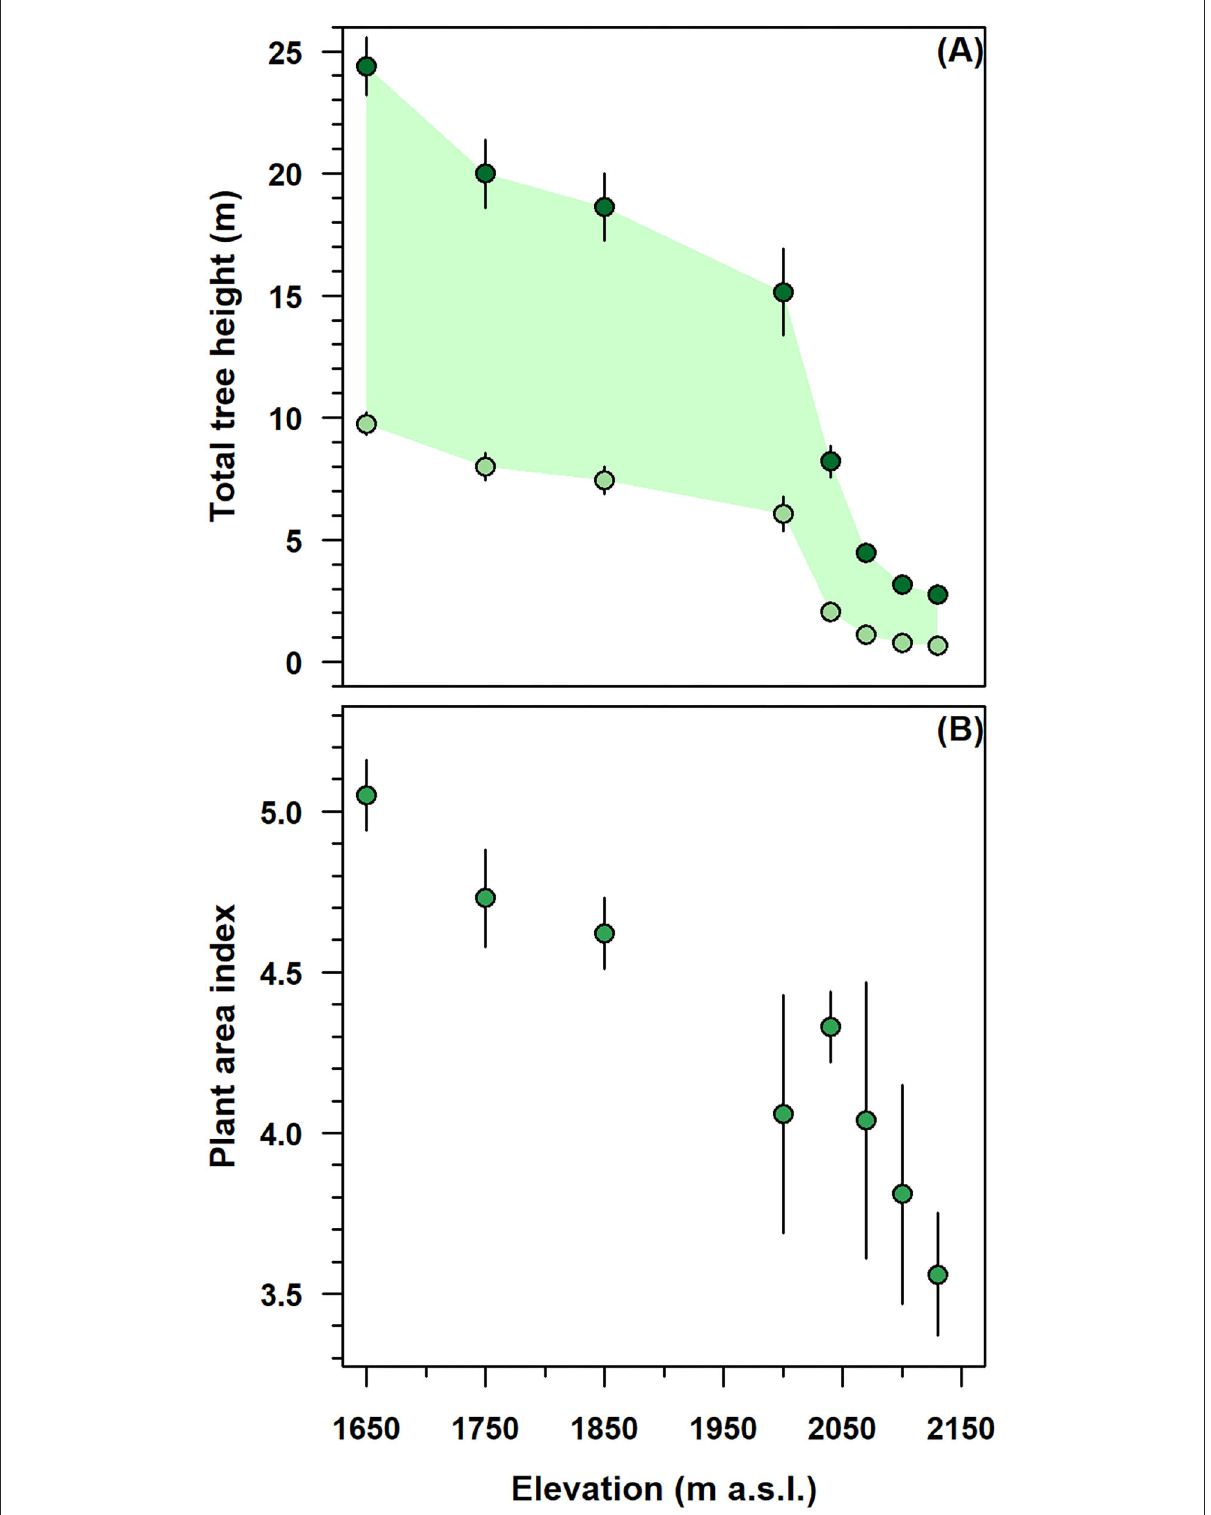
FIGURE2 Elevation variation of height-related attributes and plant area index (PAI) in the single-stemmed (1,650–2,000m) and multi-stemmed (2,040–2,130m) F. sylvatica stands of the north-western slope of Serra del Prete mountain. (A) Dark green and light green circles denote total and live crown base tree heights, respectively, while the green band represents the live foliated crown length. (B) Green circles represent PAI. In both panels, vertical bars indicate first standard deviation